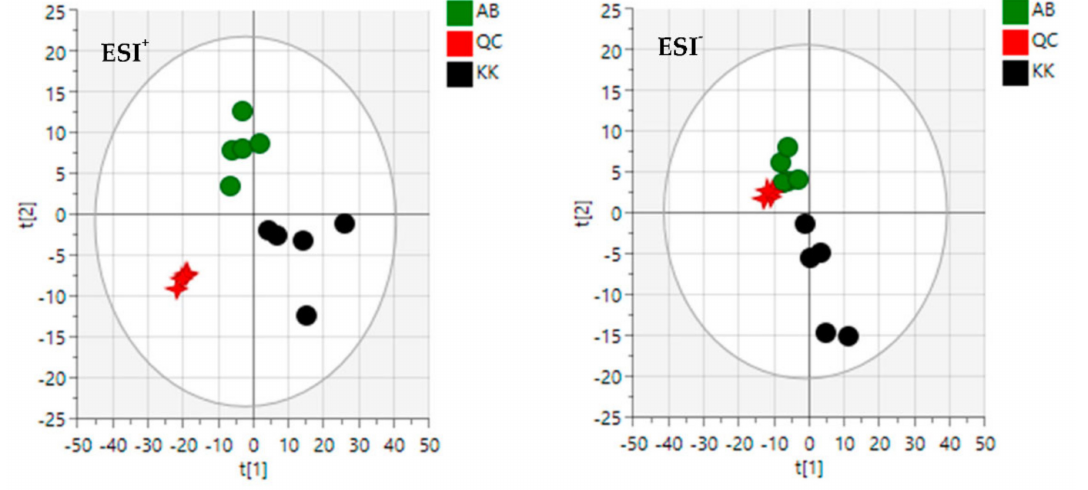
Figure 2. The principal component analysis (PCA) of VAL and OGL in ESI + mode and ESI − mode. AB—Abraka; KK—Kokori; QC—Quality control.